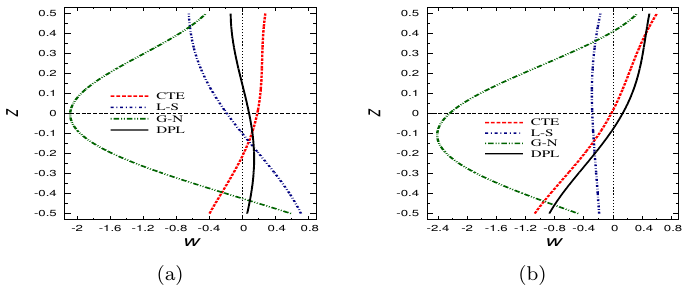
Figure 7. The transverse deflection distributions in the thickness direction for beams under (a) thermal load and (b) thermomechanical load.